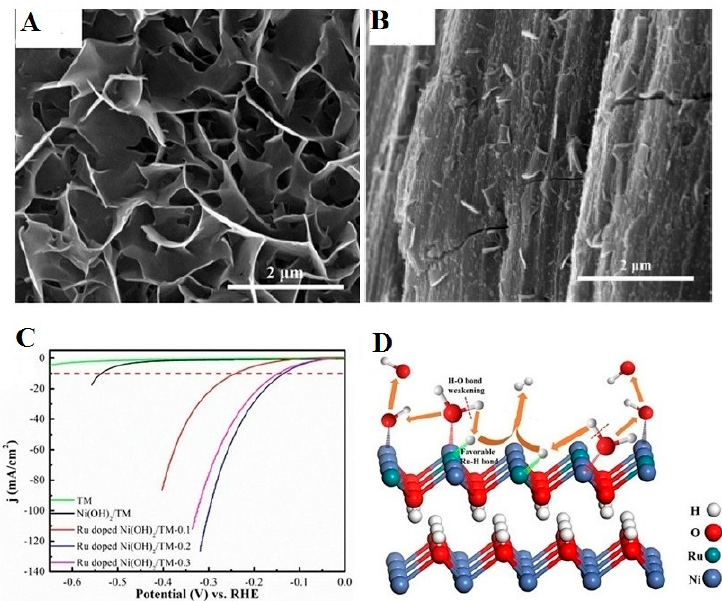
Figure 1. ( A ) SEM image of Ni(OH) 2 /TM. ( B ) SEM image of Ru-doped Ni(OH) 2 /TM-0.2. ( C ) Polarization curves of TM, Ni(OH) 2 /TM, Ru doped Ni(OH) 2 /TM-0.1, Ru doped Ni(OH) 2 /TM-0.2, and Ru doped Ni(OH) 2 /TM-0.3. ( D ) The proposed synergistic effect in Ru doped Ni(OH) 2 /TM for HER (reprinted with permission from ref [40]. Copyright © 2019, Elsevier).